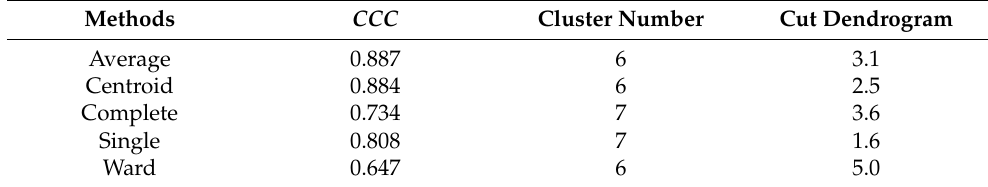
Table 2. Comparison of the results of the execution of the most used methods for clustering.